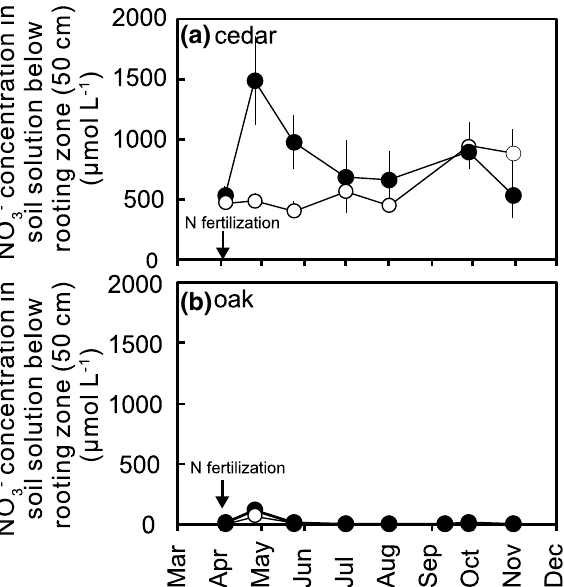
Figure 1. Changes in the NO 3 − concentration in the soil solution below the rooting zone (50 cm depth) in the ( a ) Japanese cedar and ( b ) oak plantations during the study period from April to November 2018. The error bars indicate the standard errors ( n = 5). The open circles refer to the unfertilized plots; the closed circles refer to the fertilized plots. The arrows indicate the timing of the addition of N fertilizer (50 kg N ha −1 year −1 as ammonium nitrate) to the surface of the forest floor. A two-way repeated measures ANOVA indicated that the difference is significant between tree species (cedar and oak) ( p < 0.01), fertilization ( p < 0.05), and their interactions ( p < 0.05).